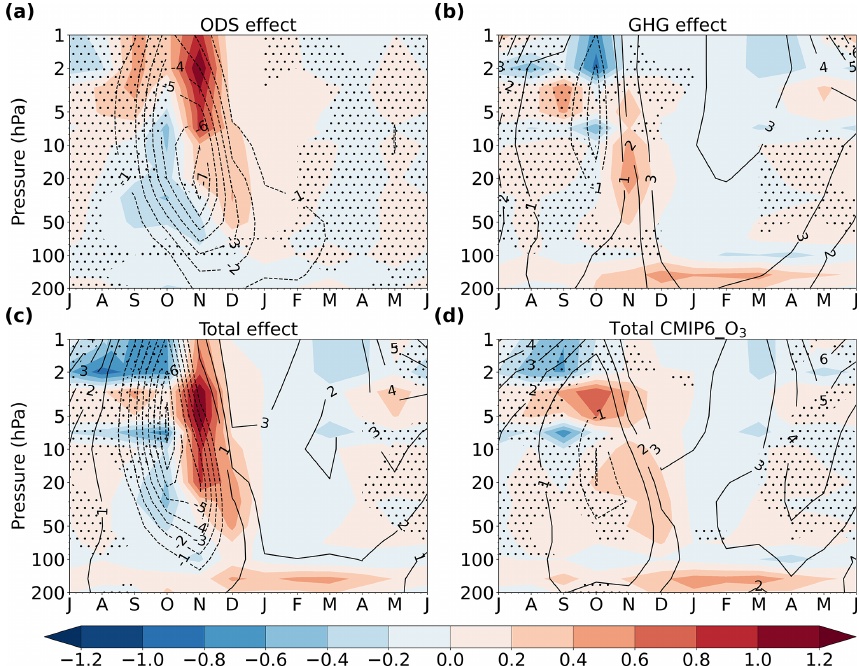
Figure 12. Changes in the divergence of the EP flux averaged over 45–80 ◦ S (ms − 1 d − 1 ) for each month and pressure level (color shading): effect of ozone recovery (a) , effect of GHGs (b) , total effect in INTERACT_O 3 (c) , and total effect in CMIP6_O 3 (d) . The contours depict the corresponding changes in the zonal-mean wind averaged over 45–80 ◦ S (ms − 1 ). The stippling masks regions where the changes are not significant at the 95% confidence interval based on a two-tailed t